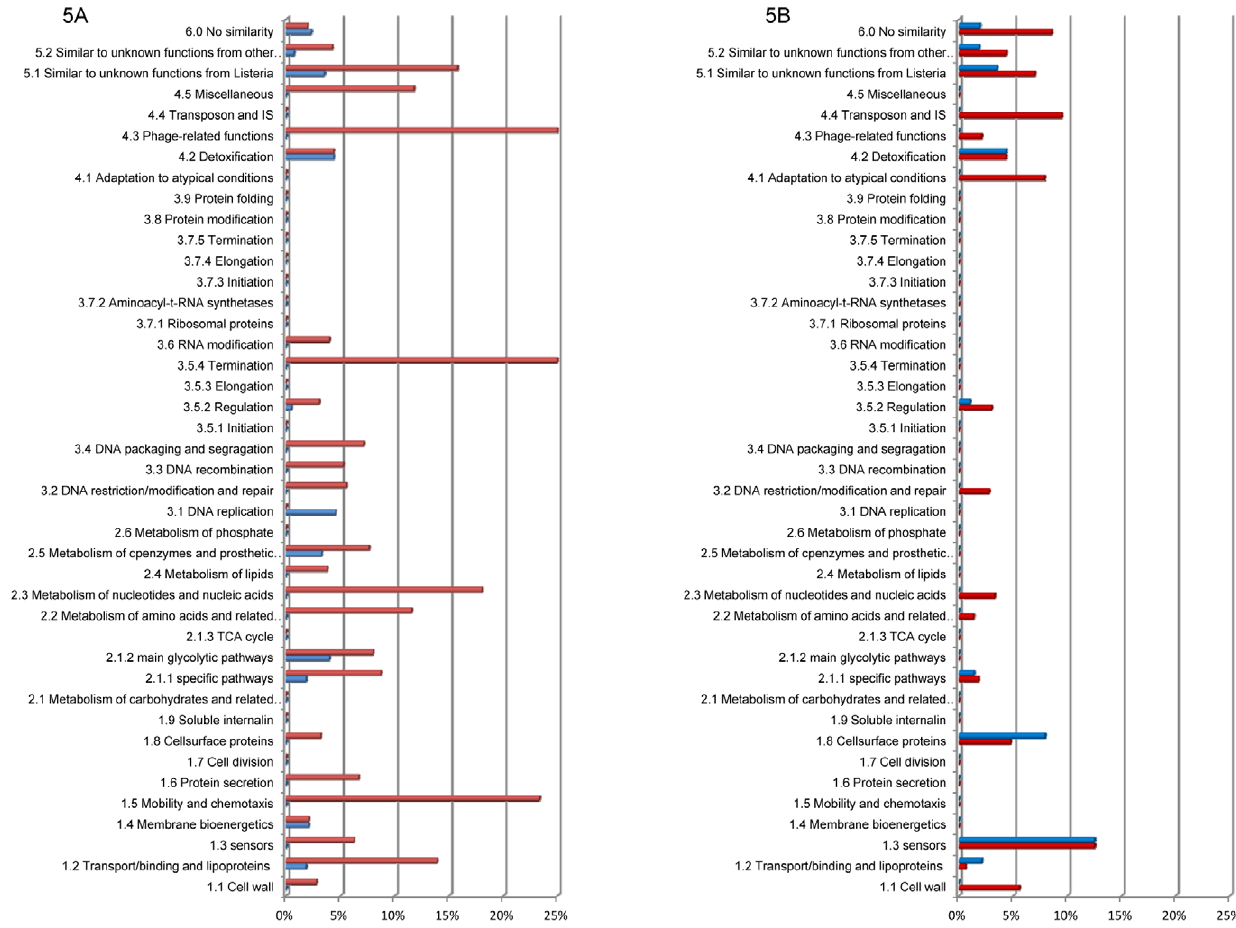
Figure 5. Percentage of genes varying significantly in the comparison DG125A versus EGD-e at 25 6 C (blue boxes) and 37 6 C (red boxes), distributed within functional categories. (A) genes with higher transcript levels; (B) genes with lower transcript levels.